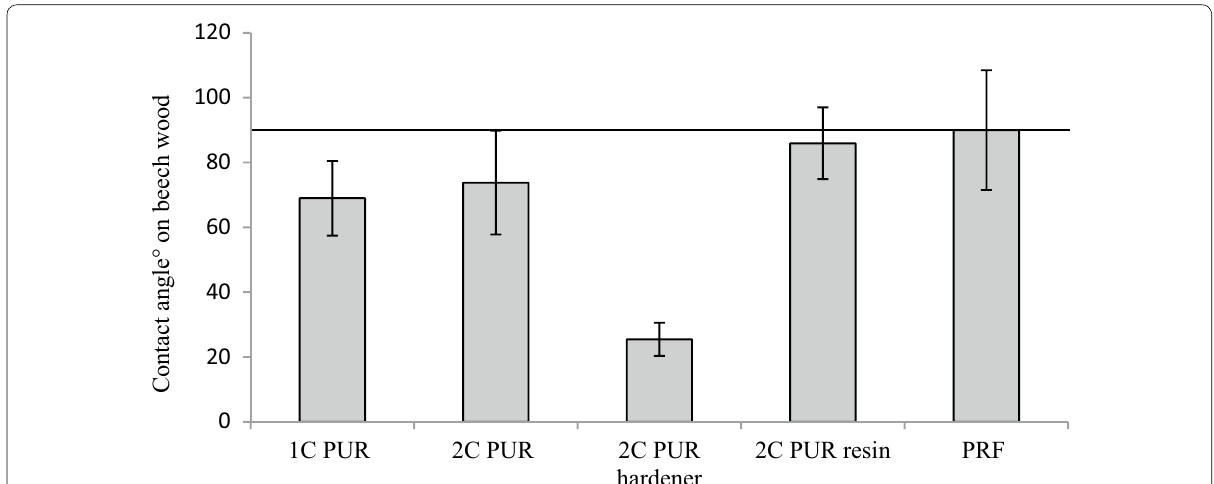
Fig. 2 Mean value and standard deviation of contact angle of adhesives and adhesive components on fresh planed beech wood on its radial plane ( n 10) at room temperature in liquid state. Horizontal line marks the border for favorable wetting (> 90°) =